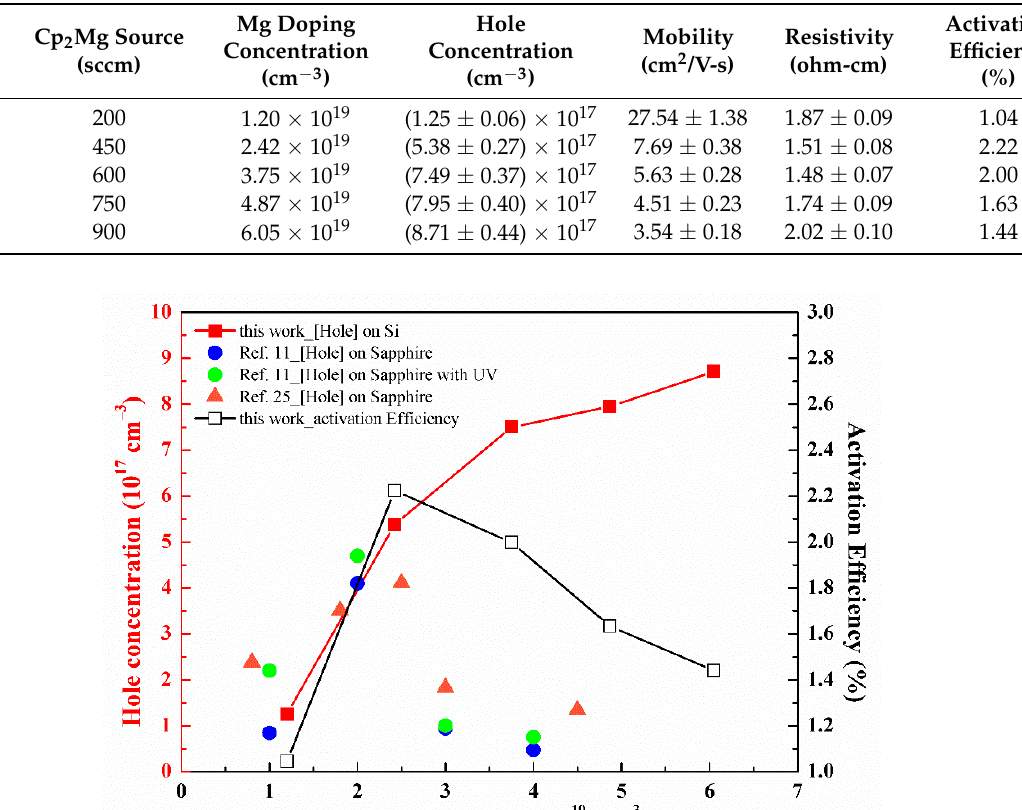
Table 1. Dependence of activation efficiency and electrical properties on the Cp 2 Mg flow rates.